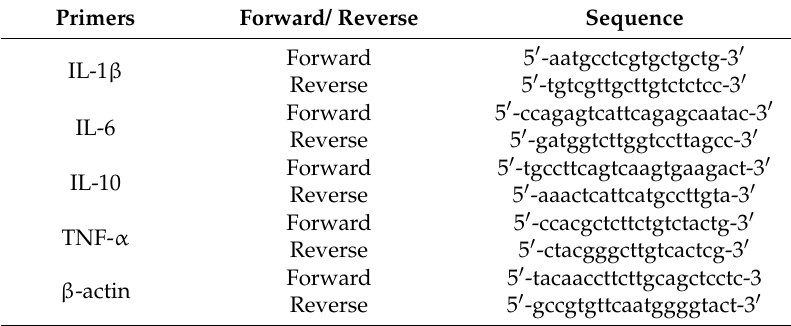
Table 1. Primers used for IL-1 β , IL-6, IL-10, TNF- α and